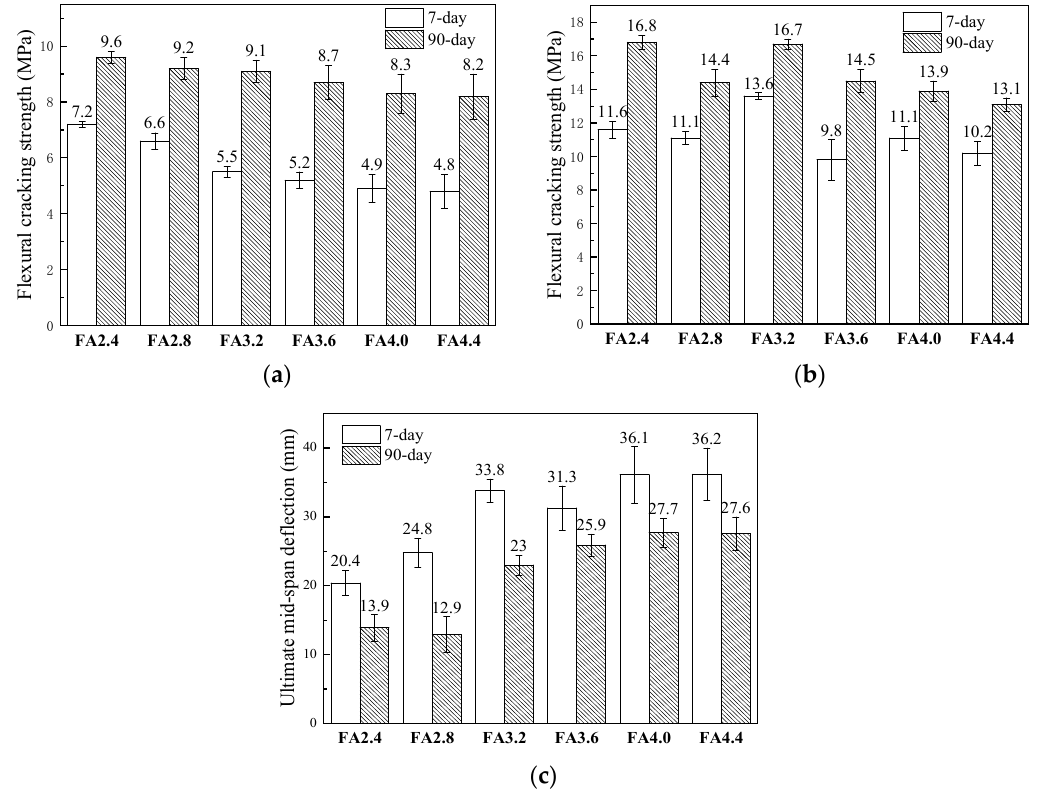
Figure 14. Comparison of bending behavior of specimens with different mixes and ages. ( a ) Flexural cracking strength; ( b ) flexural strength; ( c ) ultimate mid-span deflection.